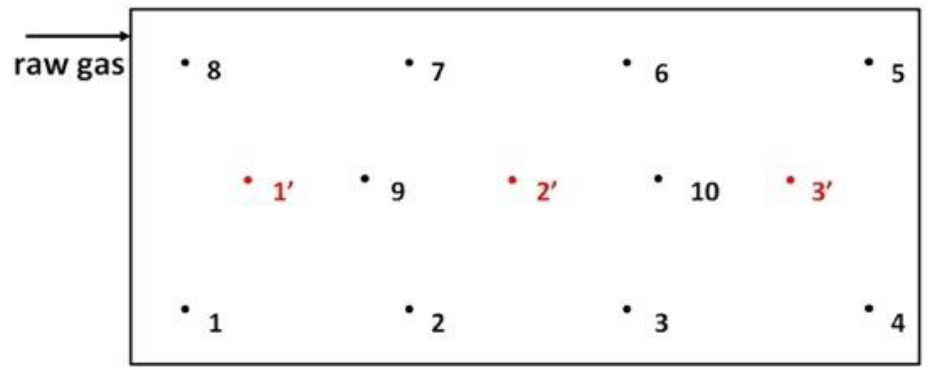
Figure 2. Sample points locations, points 1 – 10 gases sampling, points 1′–3′ filling material sampling.